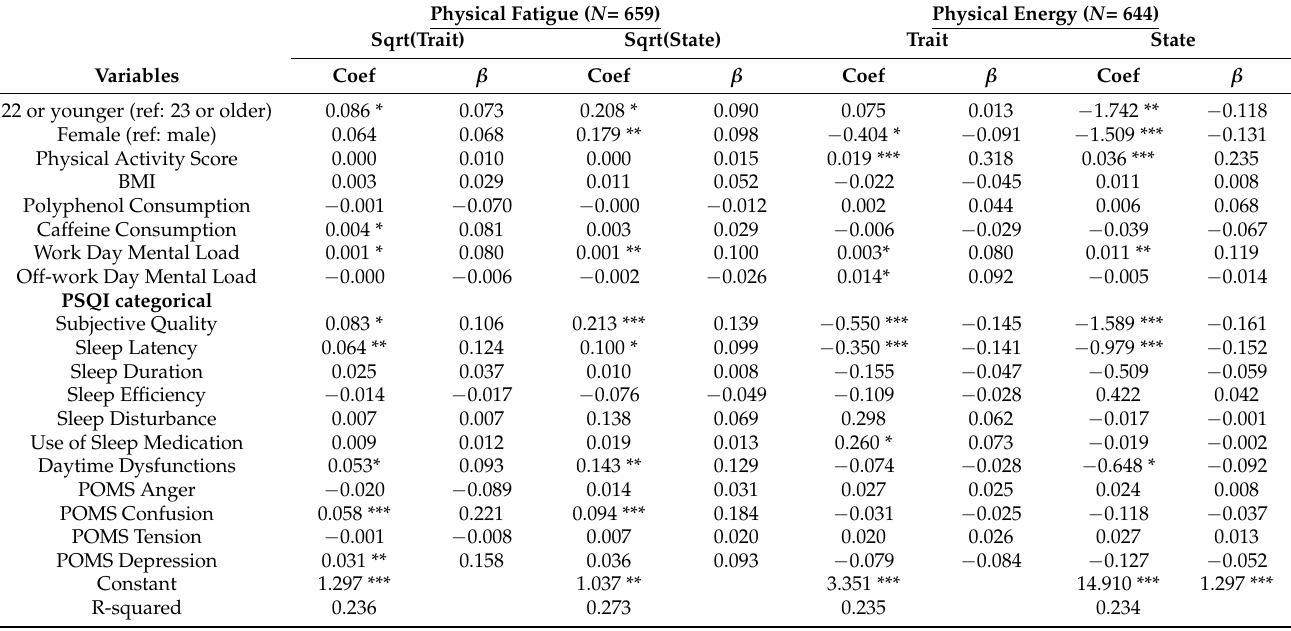
Table 5. Comparing predictors of trait and state physical energy and fatigue with PSQI variables being